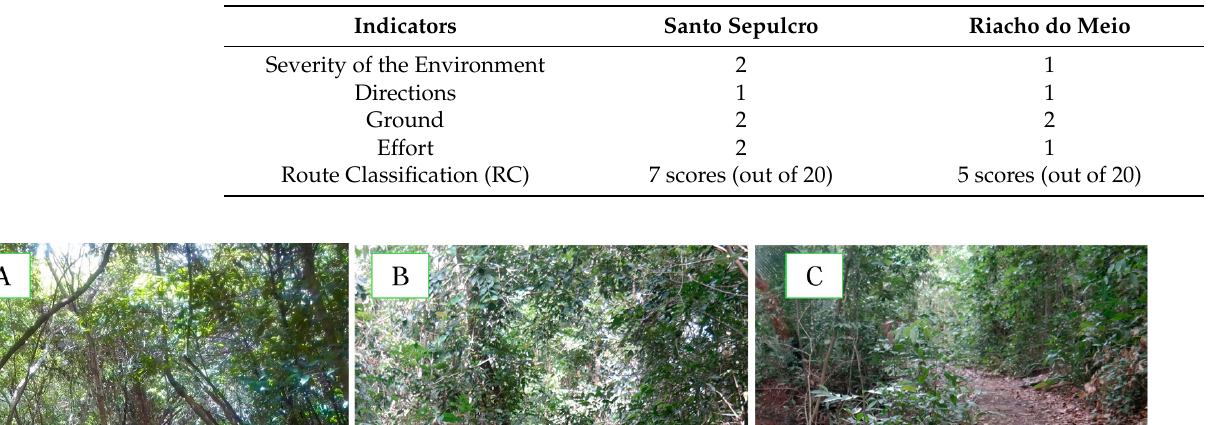
Figure 11. Ground conditions of the Riacho do Meio trail; Araripe UGG. Source: Research Collection. ( A )—Compacted soil and single track; ( B )—Wooden stairs; ( C )—Paths with streams on the bank.